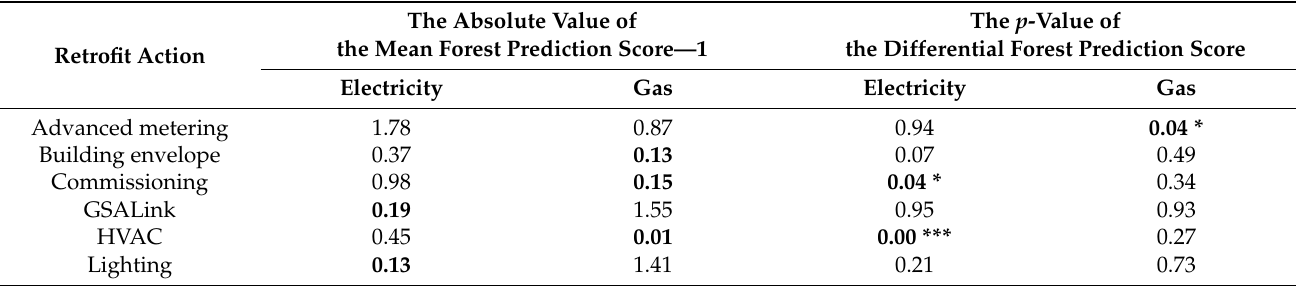
Table 6. Model performance in the prediction of the mean and effect heterogeneity of the six retrofit actions.